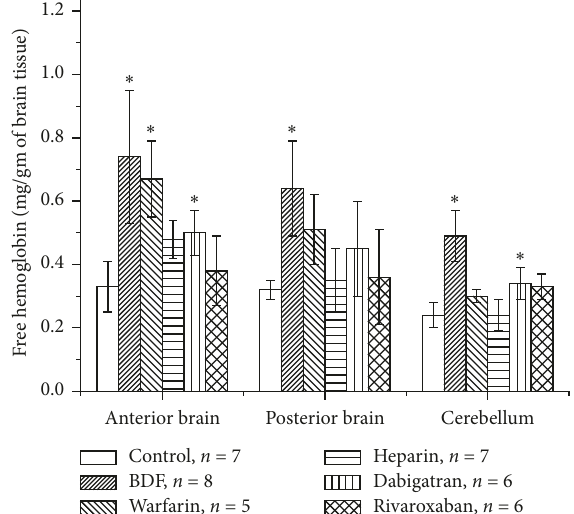
Figure 2: Free hemoglobin concentration in the brain tissue in rats treated with different anticoagulants . Hemoglobin concentration was measured as mg of free hemoglobin per gram of the brain tissue. ∗ 𝑝 < 0.05 compared to control.